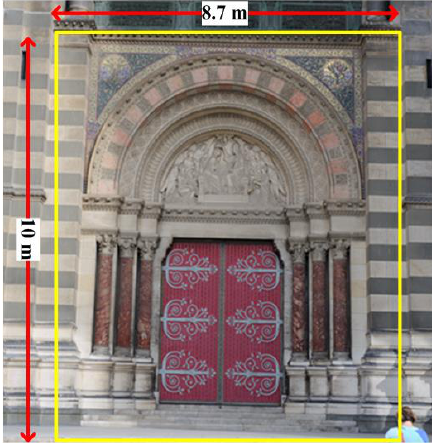
Figure 1. Test-object and dimensions (Cathédrale de la